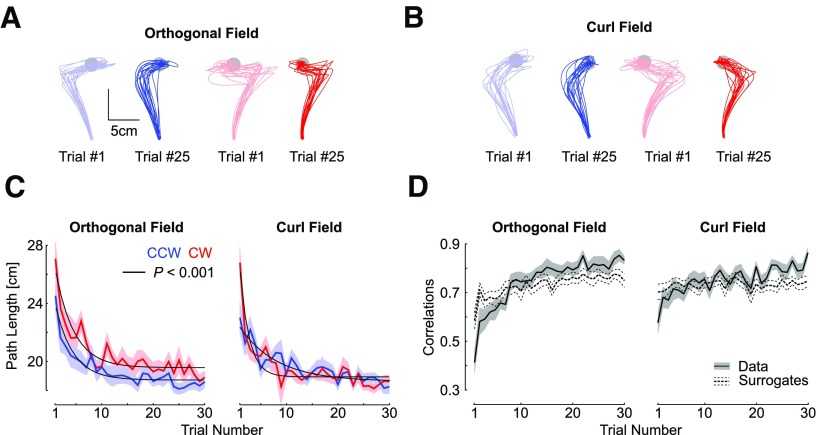

A, Hand paths from the first (light colors) and 25th (dark colors) trials with an orthogonal field chosen to illustrate changes in feedback responses. All data were taken from experiment 2, and each trace represents trials taken from each participant (n = 18). Blue and red traces represent counter clock-wise and clockwise perturbations. B, Same as panel a for the curl field. C, Path length across force field trials. D, Trial by trial correlations between the lateral commanded force (proportional to forward velocity) and the measured force. Correlations were averaged across counterclockwise and clockwise directions. The shaded areas represent one SEM across participants. The dashed traces (mean ± SEM) are the correlations between the measured lateral force and the commanded force corresponding to the velocity of randomly picked trials with replacement. The procedure was repeated 100 times for each participant, and the results were averaged across CCW and CW perturbations directions.